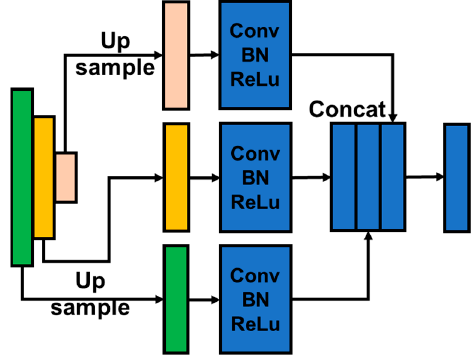
Figure 10. The structure of the CP branch.